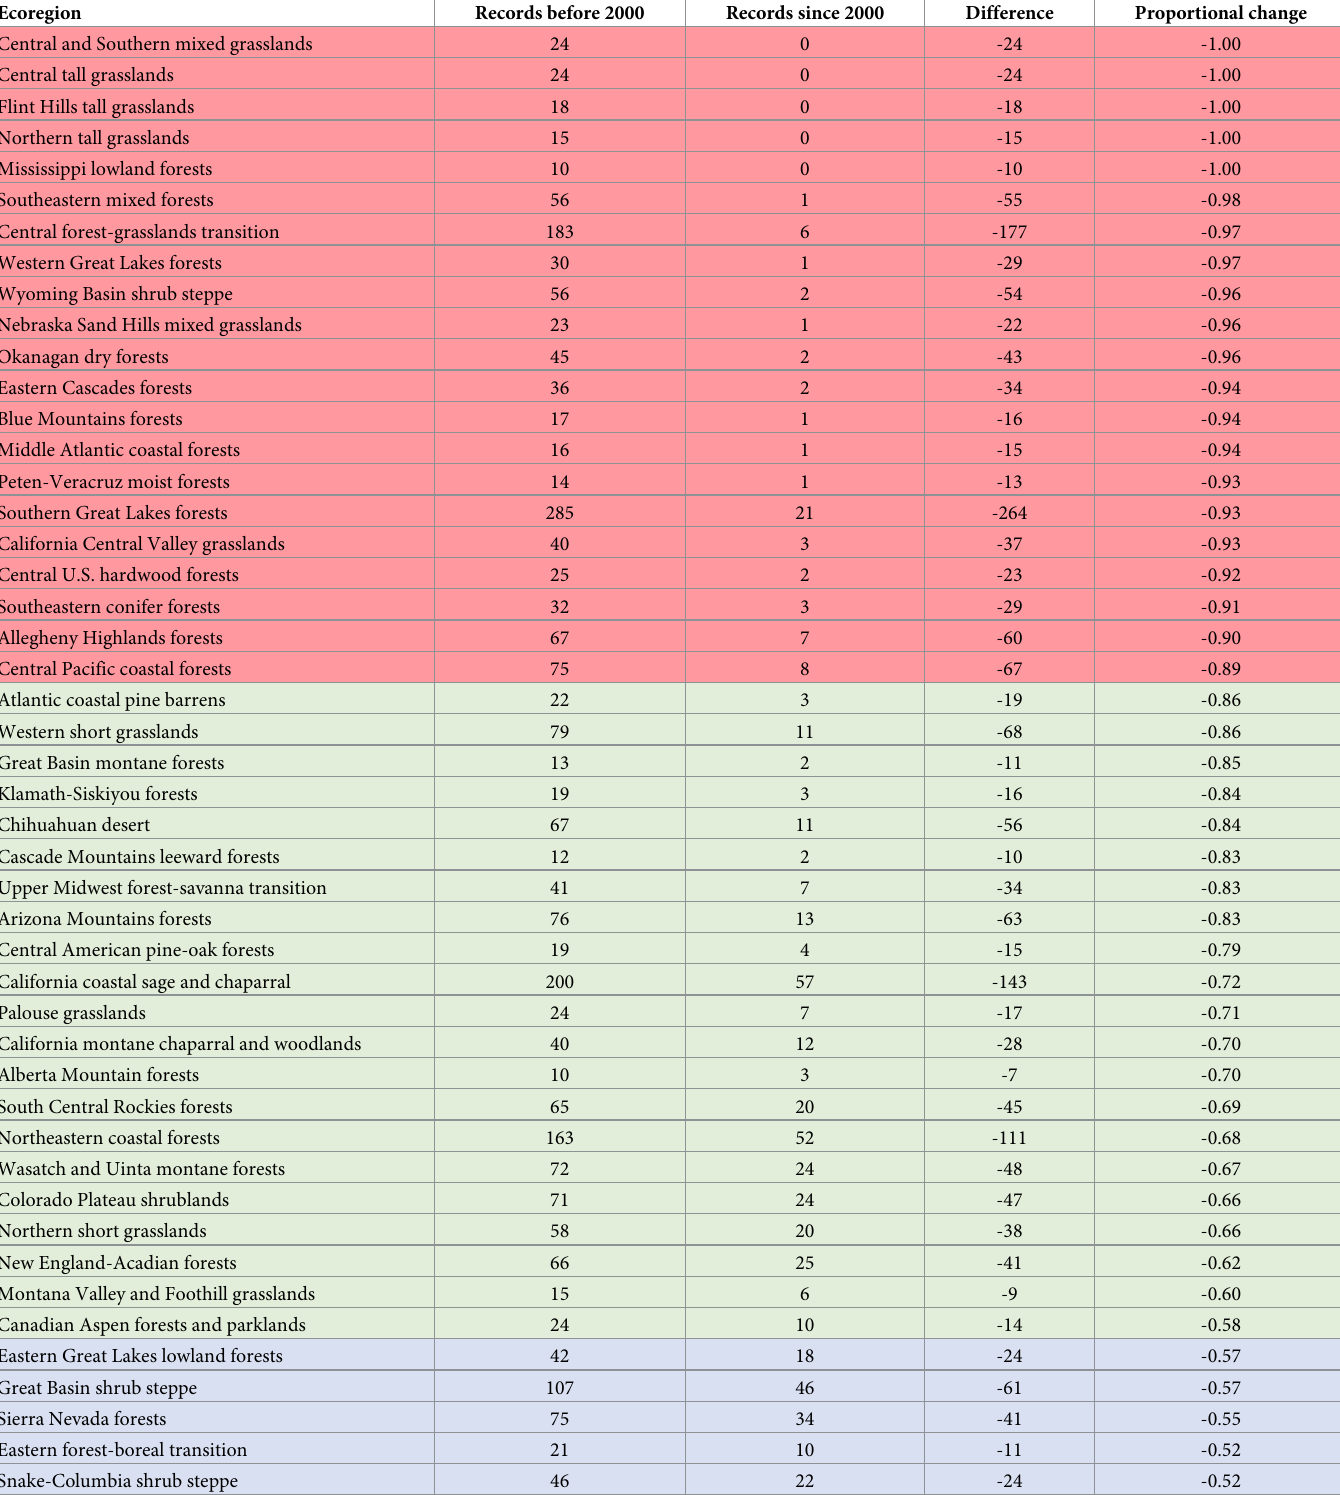
Table 4. Change in the number of museum and iNaturalist records of Mustela frenata per ecoregion before 2000 and from 2000 and after that year. Ecoregion Records before 2000 Records since 2000 Central and Southern mixed